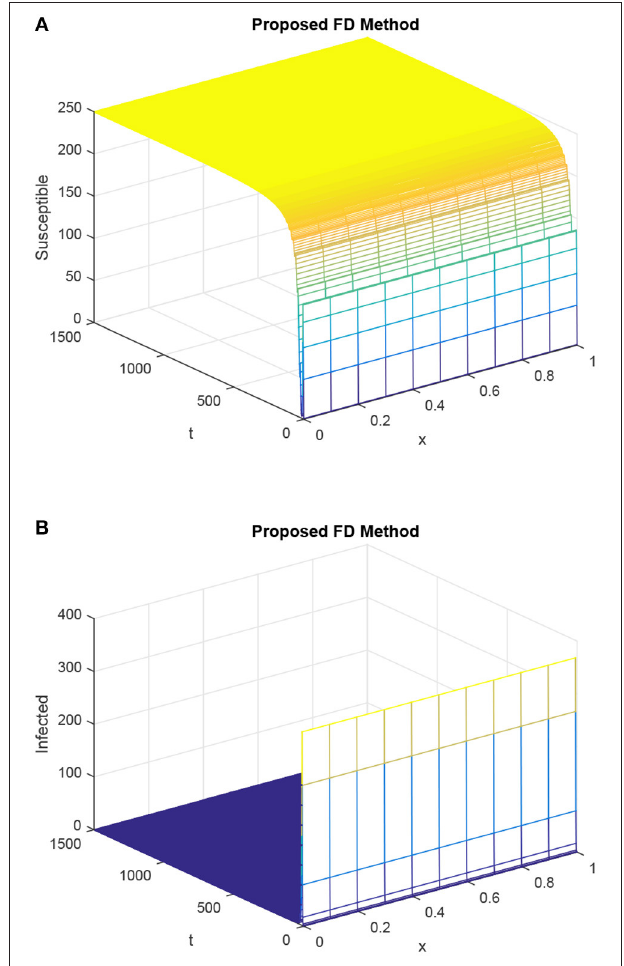
FIGURE 7 | Mesh graphs for the susceptible population and infected population by our proposed method, giving the parametric values as h = 0.1 and R 1 = R 2 = 0.15, τ = 12. (A) Mesh graph of S . (B) Mesh graph of I .